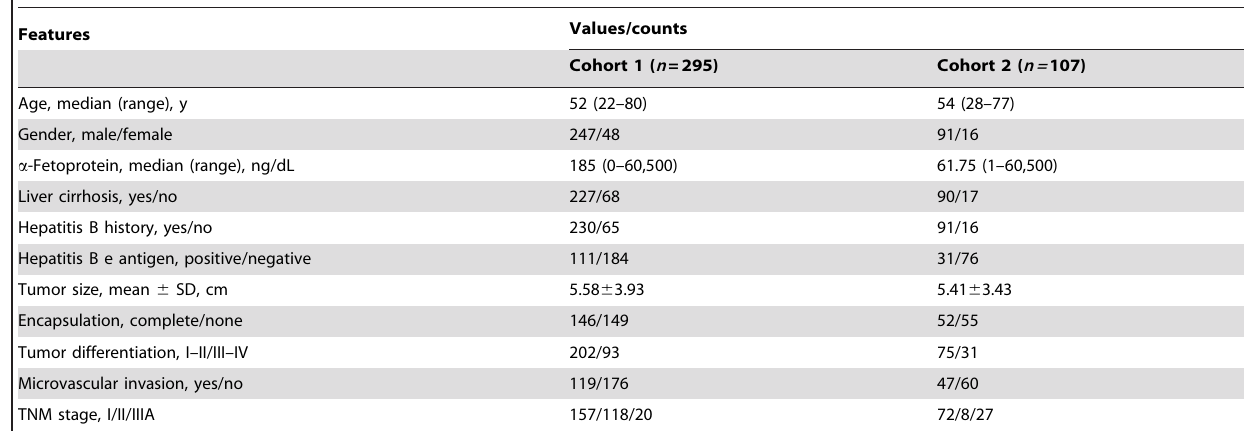
Table 1. Clinicopathologic features of patients from cohort 1 and cohort